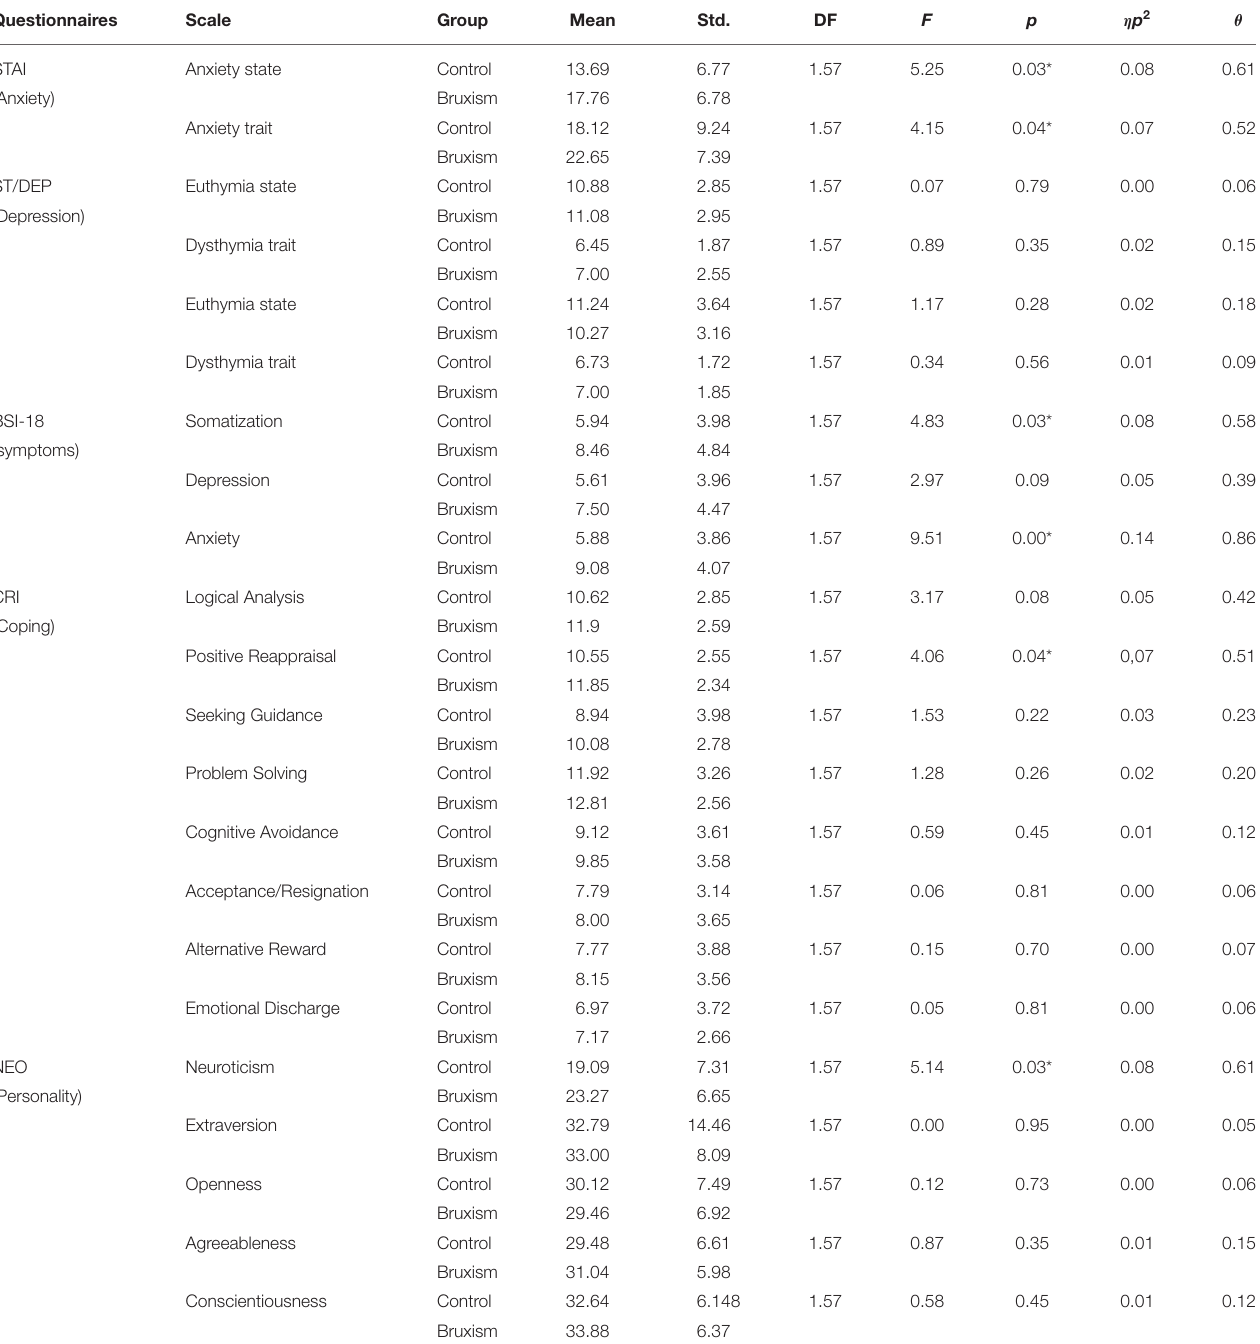
TABLE 1 | STAI (State and Trait Anxiety Inventory), ST-DEP (State and Trait Depression Inventory), BSI-18 (Brief Symptom Inventory), CRI-A (Coping Responses Inventory—Adult form), and NEO—FFI (NEO Personality Inventory) multiple analyses of variances (MANOVAs). Questionnaires Scale Group